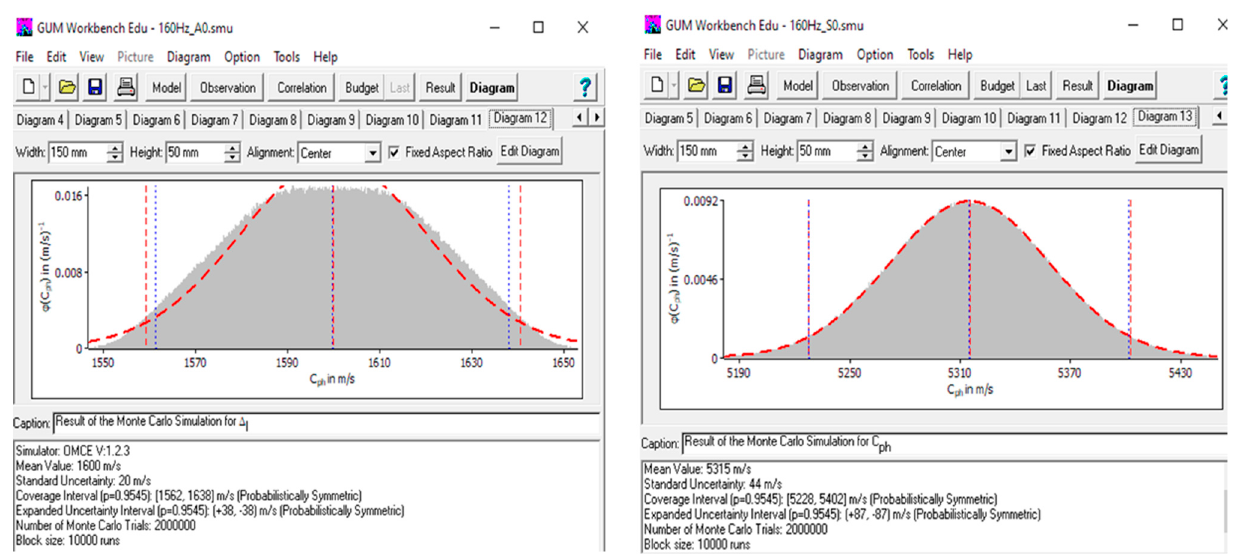
Figure 11. Expanded uncertainty of the reconstructed frequency range for the A 0 and S 0 modes, respectively, calculated by using Monte Carlo